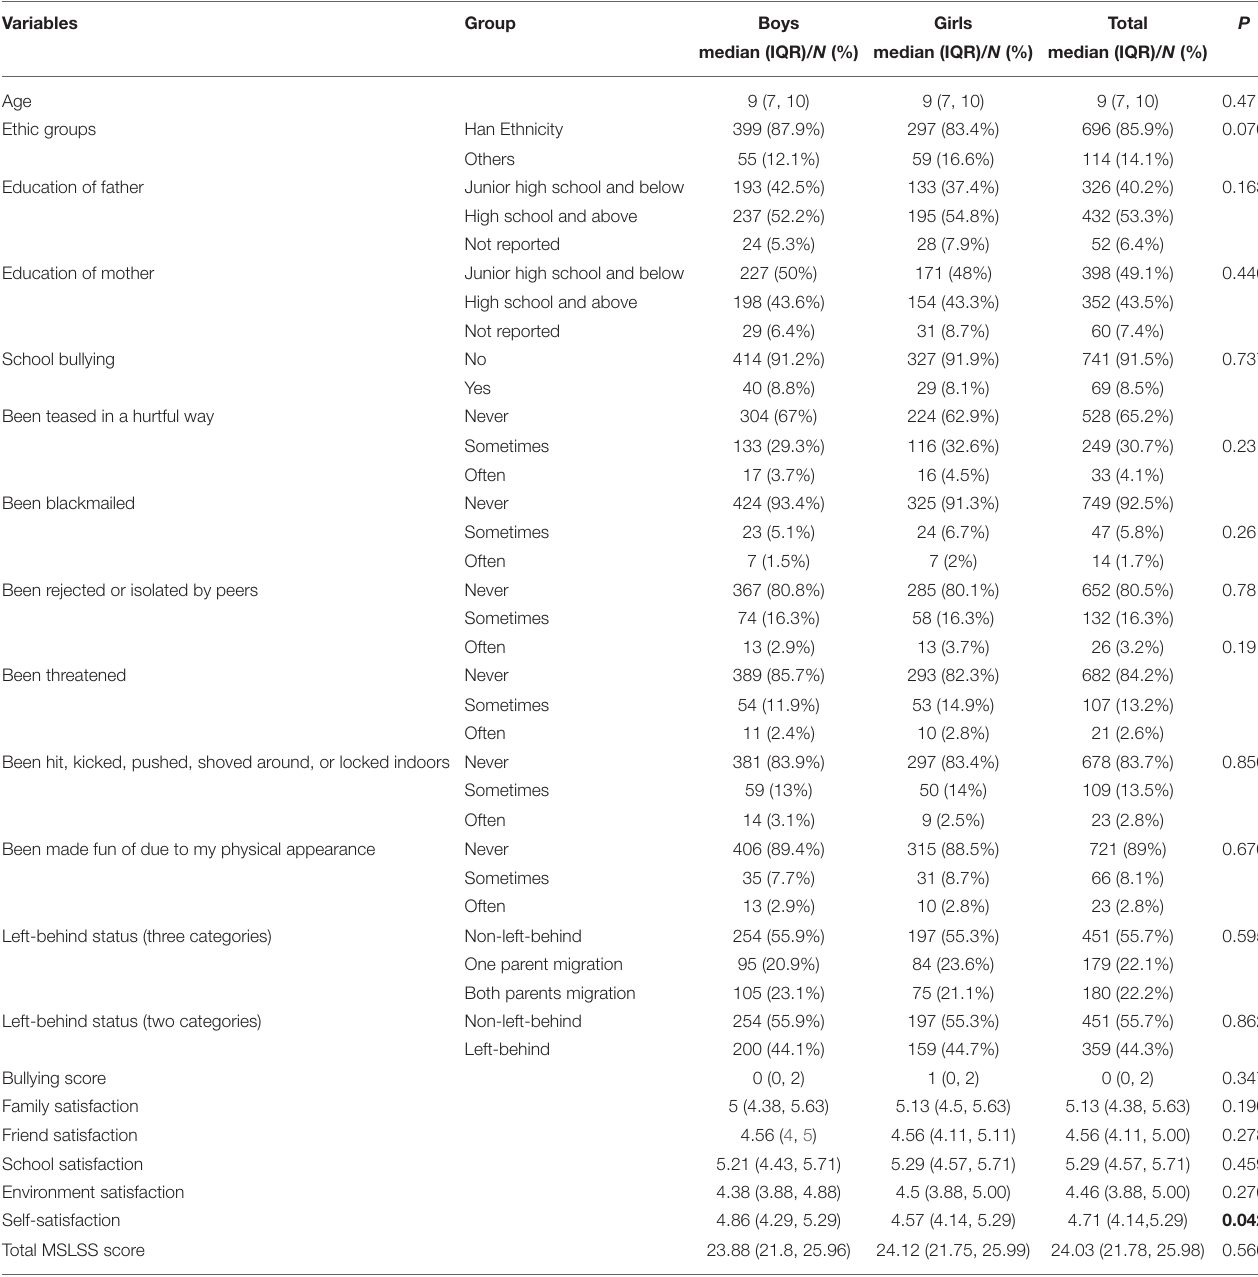
TABLE 1 | The general characteristics of the study population.